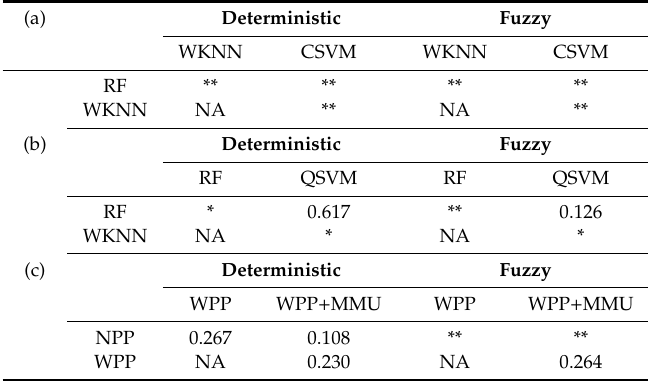
Figure A1. Deterministic accuracy (black bar) and fuzzy overall accuracy (gray bar) by zone for the top three models for the contemporary habitat model development for Dauphin Island, Alabama, USA. ( a ) Subtidal zone; ( b ) Intertidal zone; and ( c ) Supratidal / upland zone. CKNN: Coarse K-nearest neighbor model; CSVM: Cubic support vector machine model; FGSVM: Fine-scaled Gaussian support vector machine model; RF: Random forest model; QSVM: Quadratic support vector machine model; and WKNN: Weighted K-nearest neighbor model. Table A5. McNemar’s test results ( p -values) for determining whether there is a significant di ff erence between model performance for ( a ) top-performing intertidal zone models; ( b ) top-performing supratidal zone models; and ( c ) contemporary model with various levels of post-processing. CSVM: Cubic support vector machine model; NPP: Combined model with no post-processing; RF: Random forest model; QSVM: Quadratic support vector machine model; WKNN: Weighted K-nearest neighbor model; WPP: Combined model with post-processing, but no minimum mapping unit; WPP + MMU: Combined model with post-processing and minimum mapping unit; *: Significant at the p < 0.05 level; and **: Significant at the p < 0.001 level.